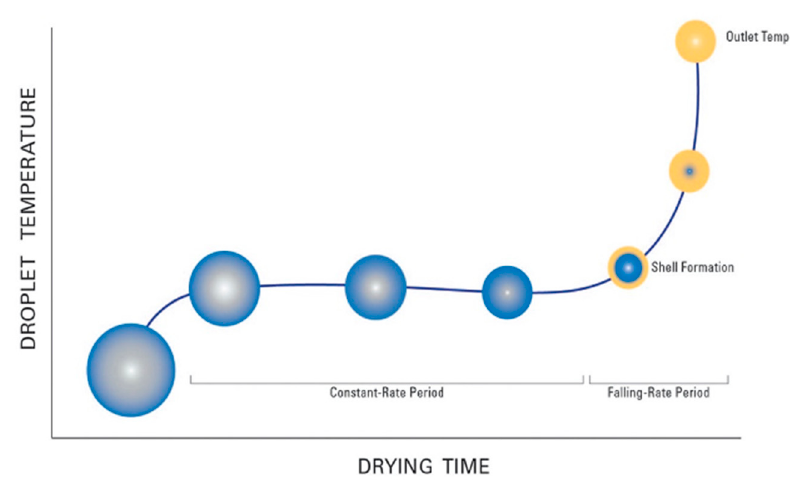
Figure 2. Two-stage droplet drying kinetics of a single droplet induced during the spray-drying process.